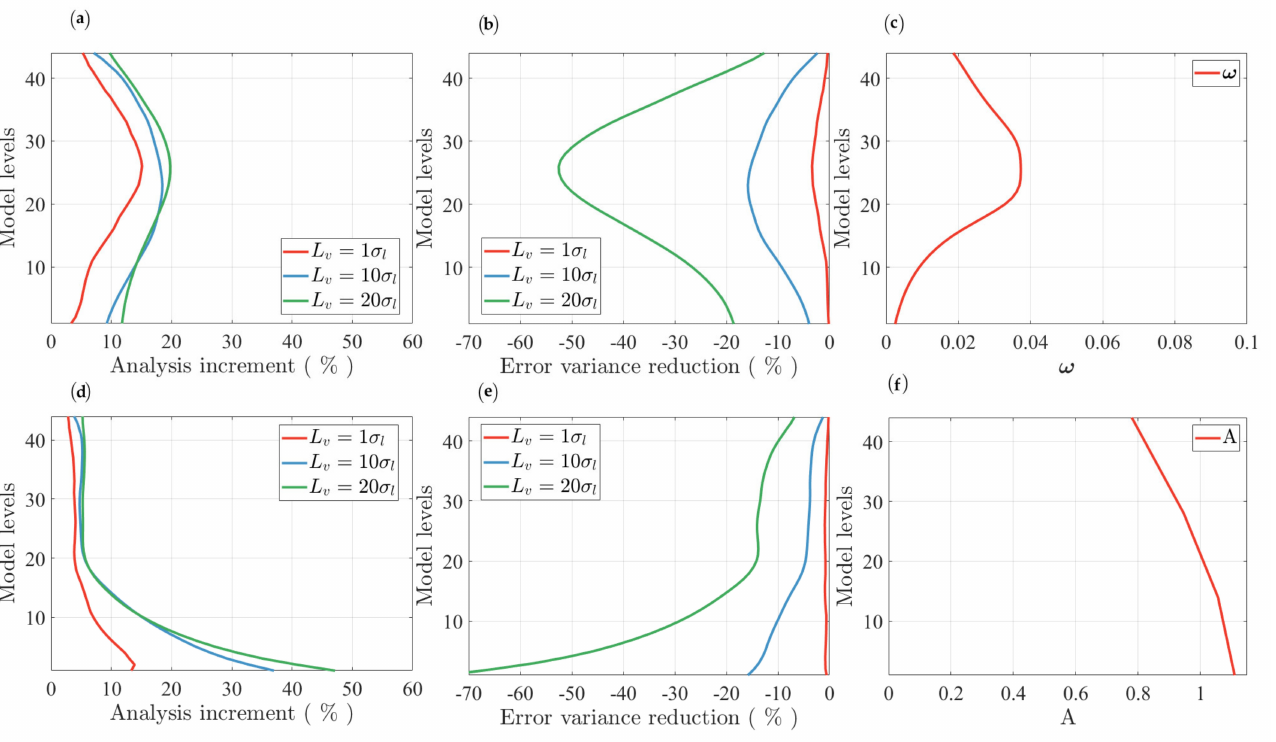
Figure 9. ( a ) Analysis increment and ( b ) error variance reduction during assimilation step for different vertical correlation length scales (red: L v = 1 σ l , blue: L v = 10 σ l , and green: L v = 20 σ l ); ( c ) Pressure weight ( ω ) at each model layer; ( d ) analysis increment and ( e ) error variance reduction where the pressure weight is considered uniform; ( f ) GOSAT column averaging